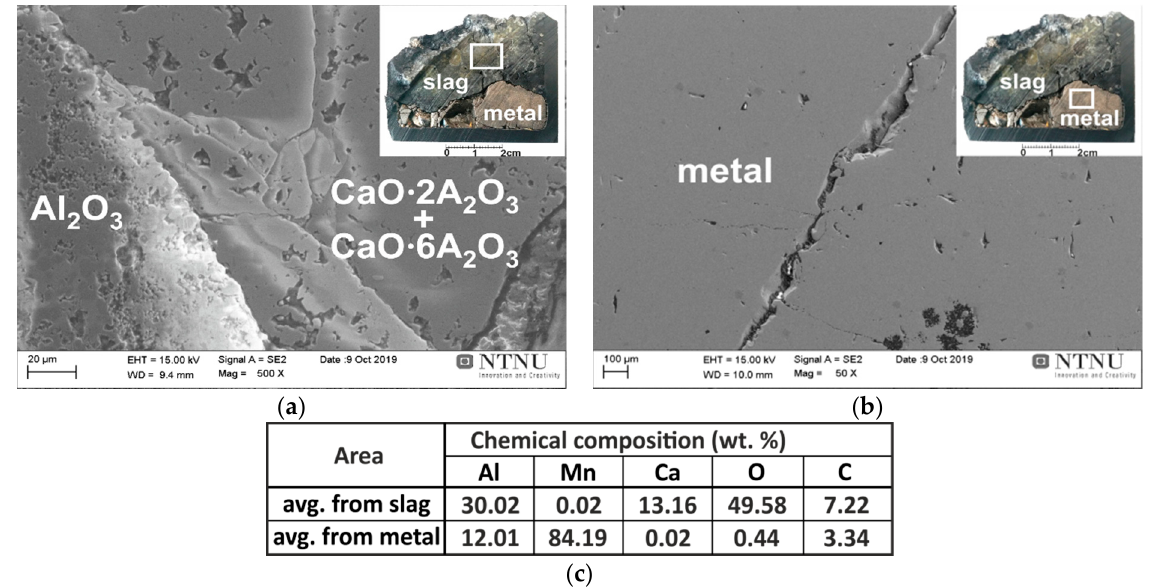
Figure 6. The SEM/EDS microstructural analysis of the cross-section of exp. 2 sample from slag area ( a ) and metal area ( b ); EDS ( c ).